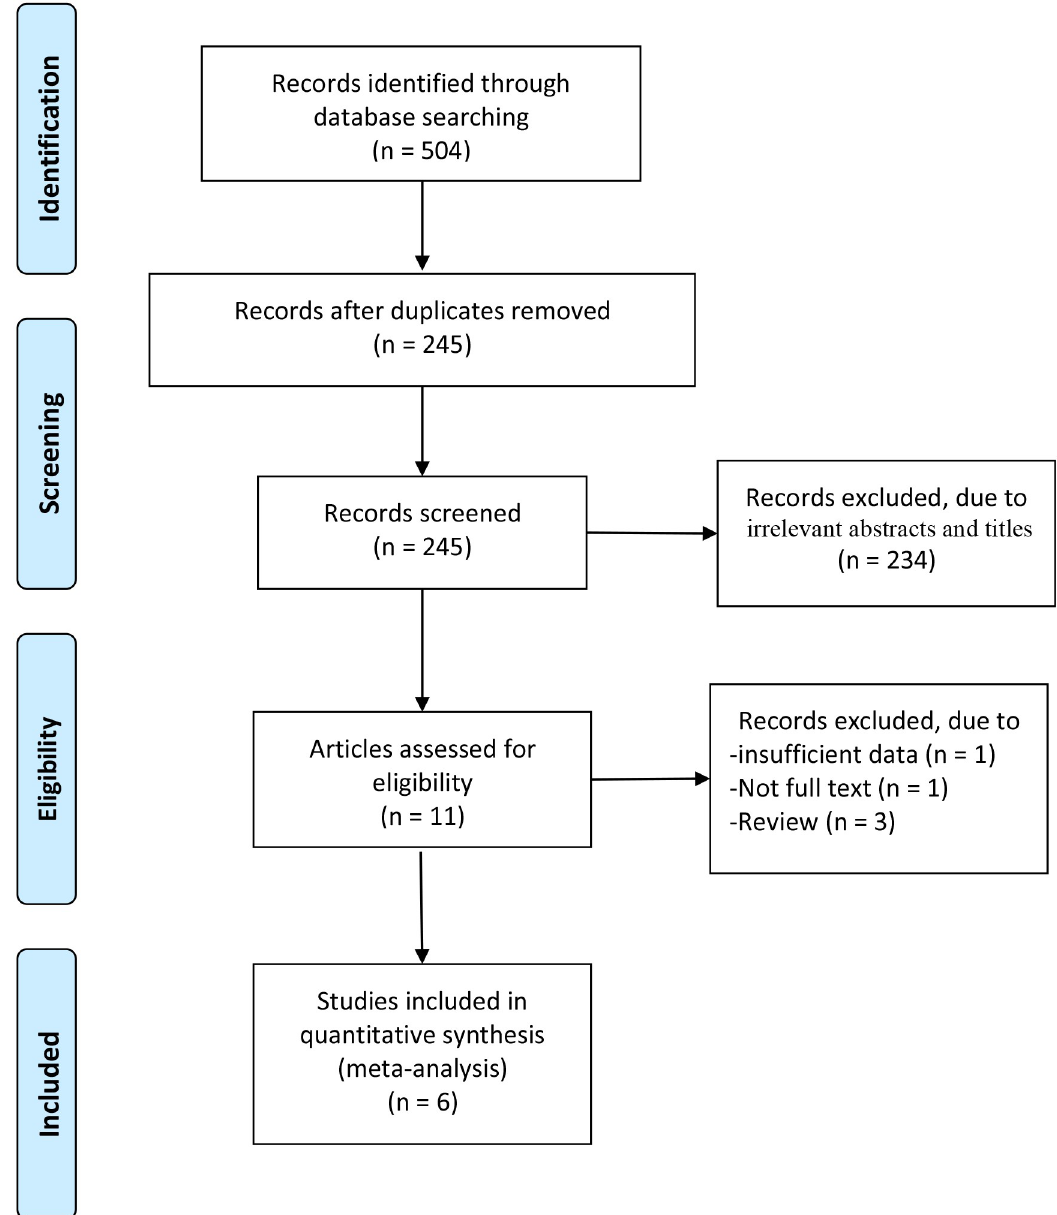
Fig 1. Flow diagram of study searching and selection